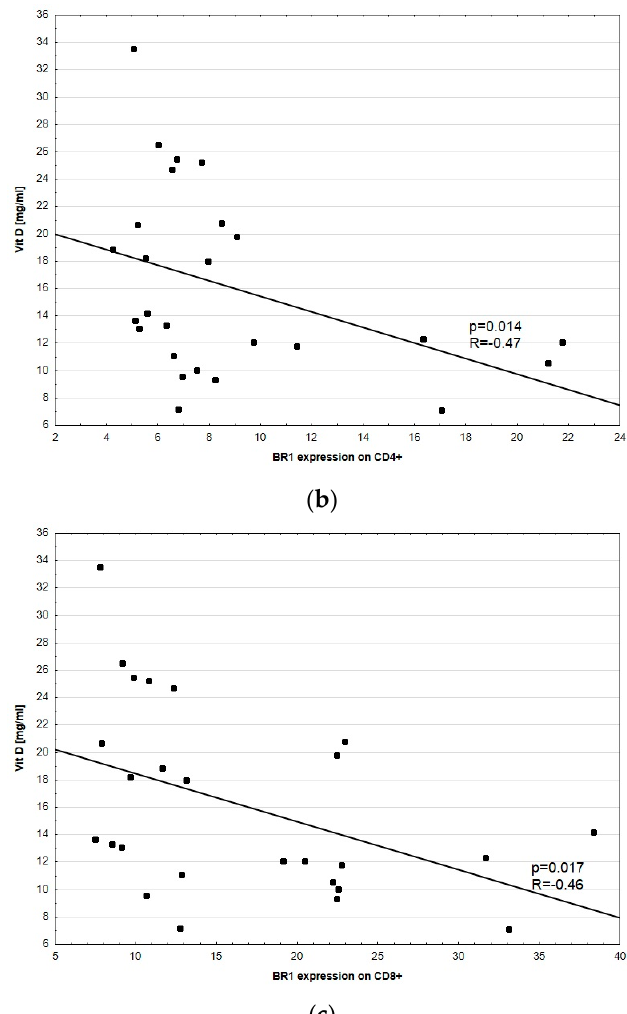
Figure 4. Correlation between vitamin D concentration and BR1 expression in ( a ) CD3 + , ( b ) CD4 + and ( c ) CD8 + cells (excluding patients No. 12, 26, and 29; no results of vitamin D). Each dot represents one patient with their ID.